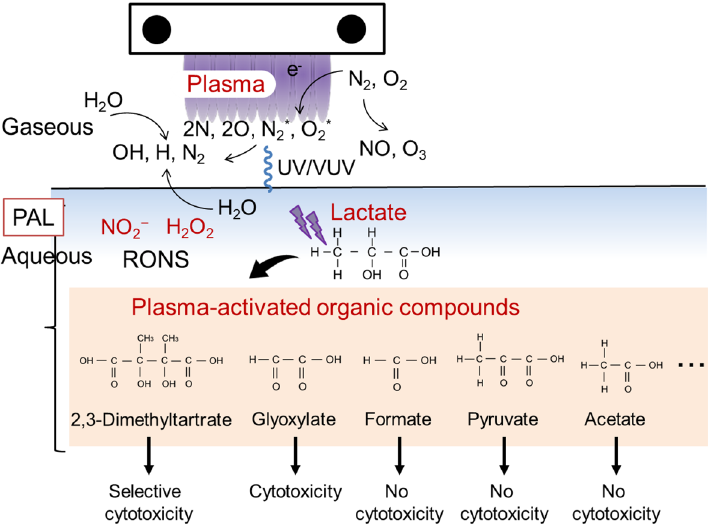
Figure 6. Components in PAL identified by the NMR analysis and direct infusion-ESI–MS/MS analysis. Among the components of PAL, 2,3-dimethyltartrate exhibited selective cytotoxicity on cancer cells, glyoxylate exhibited cytotoxicity on both cancer and normal cells, and formate, pyruvate, and acetate did not exhibit any cytotoxicity on